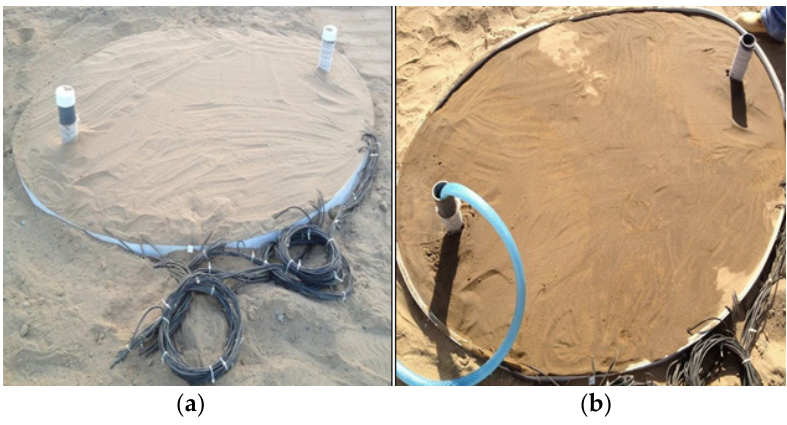
Figure 4. The sand barrel before ( a ) and after ( b ) saturation.